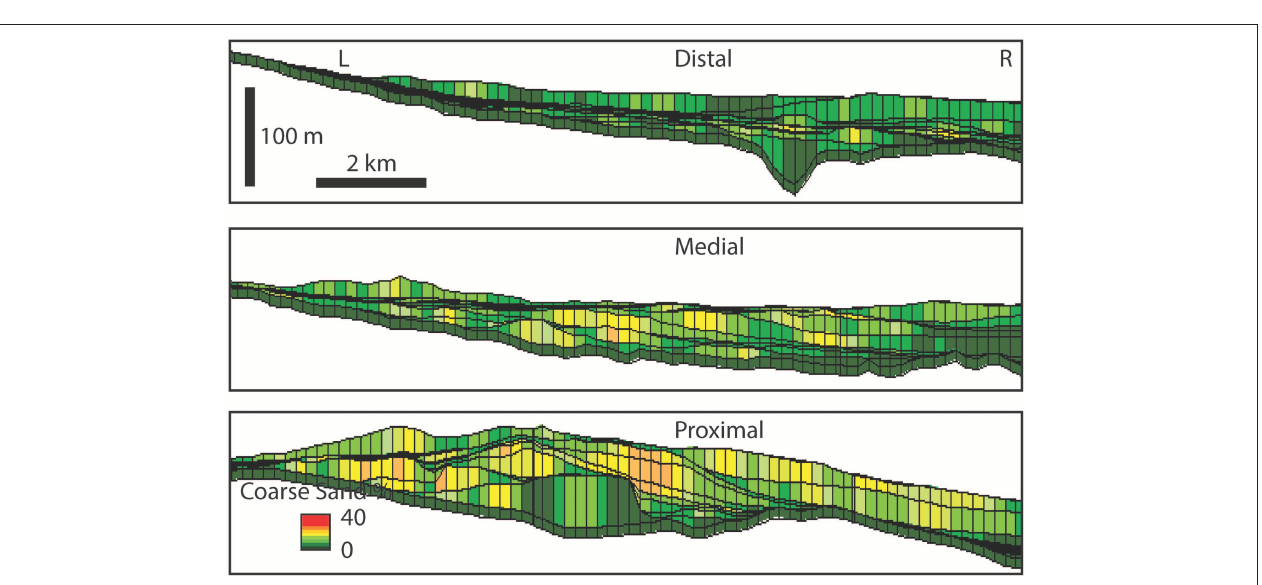
FIGURE 4 | Cross sections of the new extended reference-case model. Left (L) and right (R) orientations in cross sections are left and right in map in Figure 3A .